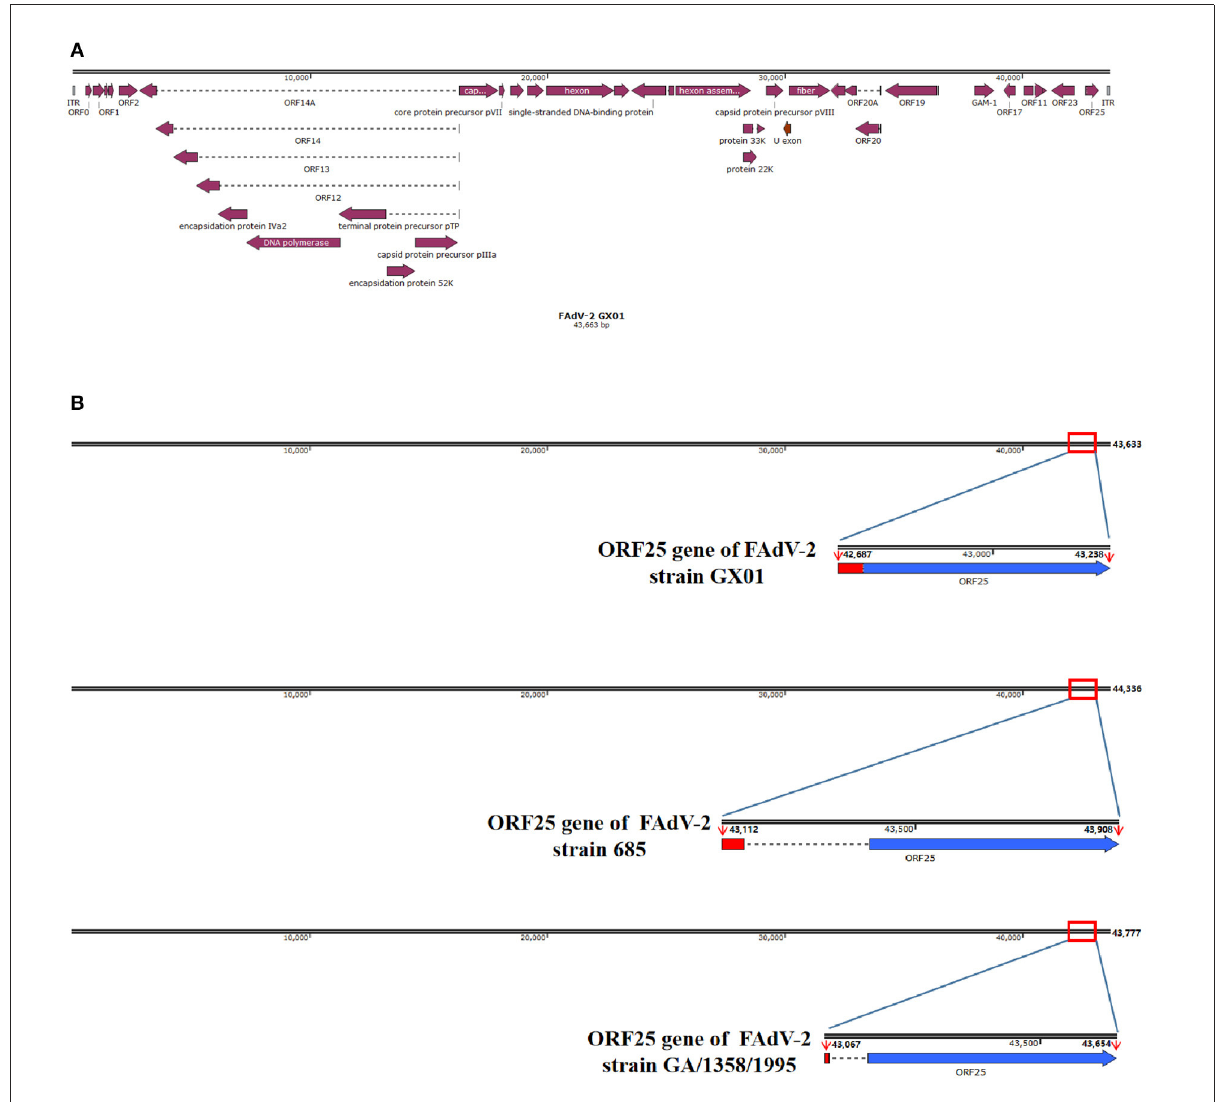
FIGURE3 Schematic representation of FAdV-2 strain GX01 and ORF25 gene. (A) The complete genome schematic representation of FAdV-2 stain GX01; (B) Comparison of ORF25 gene of FAdV-2 strain GX01 with ORF25 gene of other FAdV-2 strains (red region: the first coding sequence of ORF25; blue region: the second coding sequence of ORF25; dotted line: non-coding